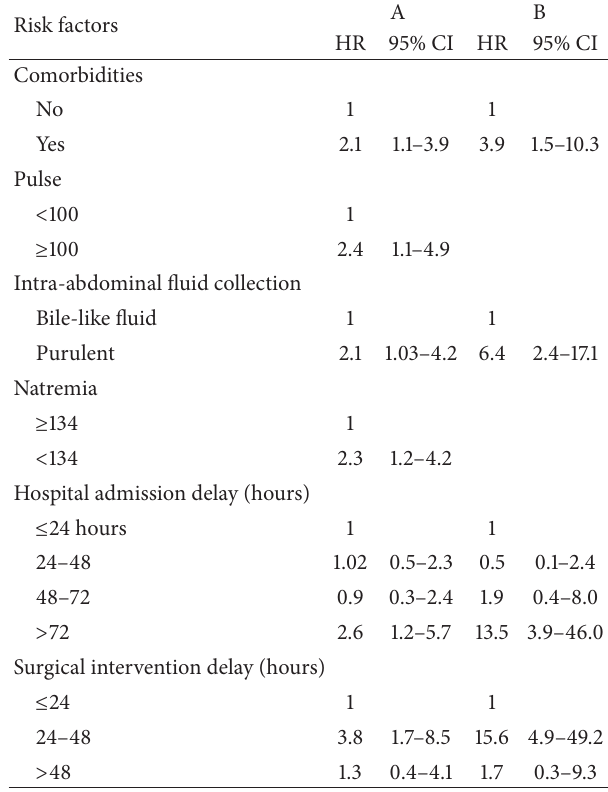
Table 2: Risk factors of postoperative complications or mortality (A) or mortality (B). Cox regression multivariate